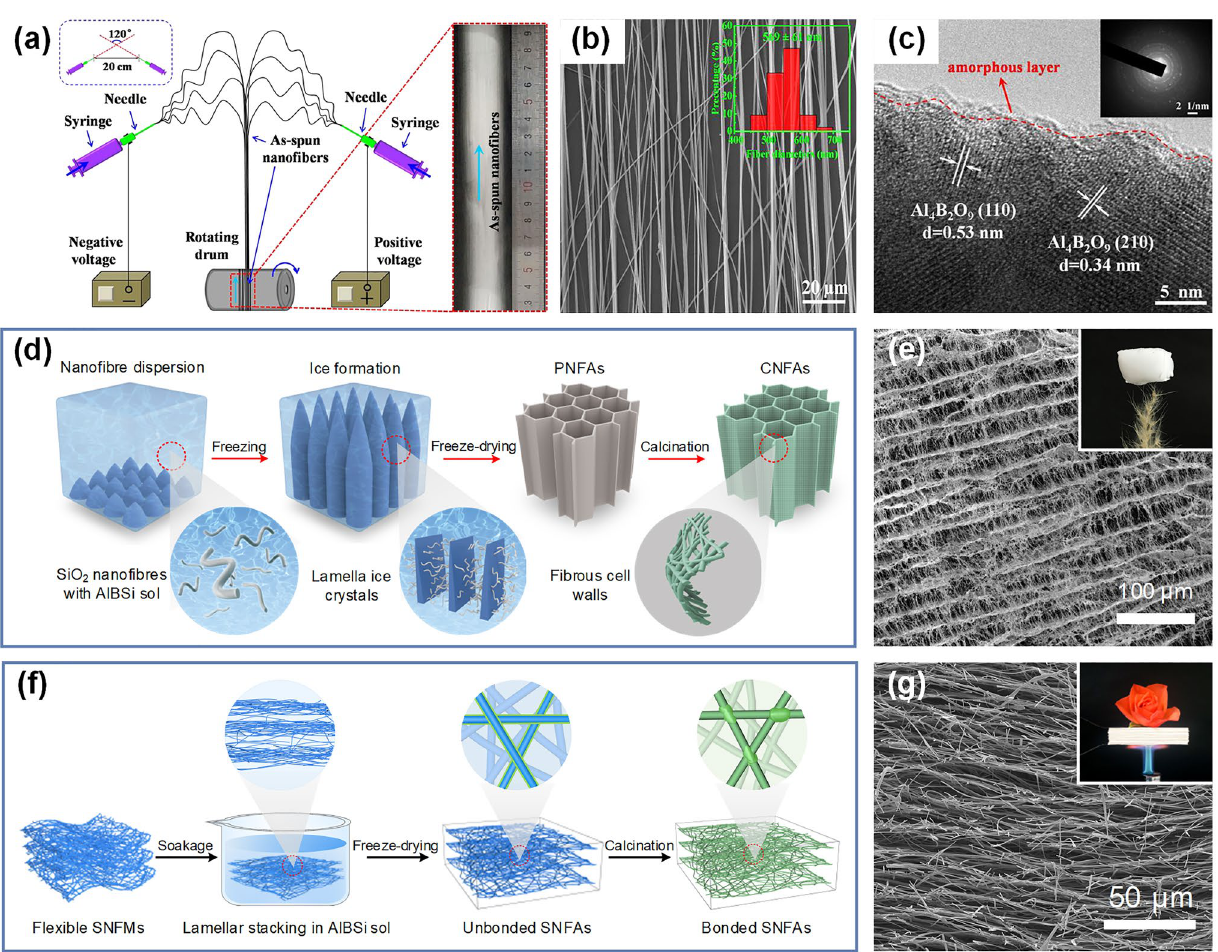
Fig. 7 a Schematic illustration of conjugated electrospinning apparatus for collecting aligned nanofibers [39]. b SEM image of aligned nanofib‑ ers after calcination. The inset is the corresponding nanofiber diameter distribution diagram [39]. c High‑resolution TEM image of aligned nanofibers after calcination. The inset is the corresponding electron diffraction pattern [39]. Copyright 2017, Elsevier. d Schematic illustration of the preparation of